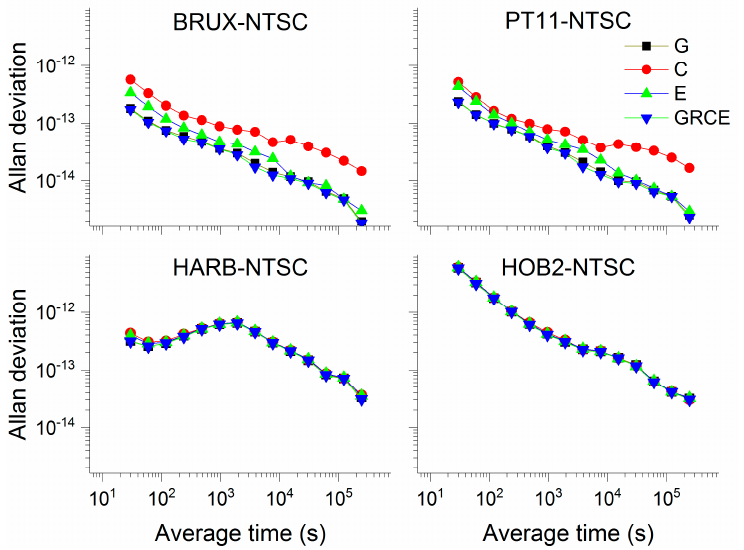
Figure 10. Allan deviation of four time links using GBM products with four models.